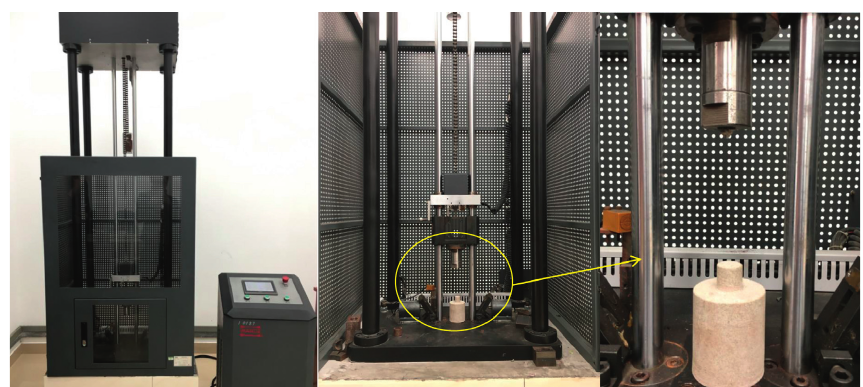
Figure 5: Process graph for the impact